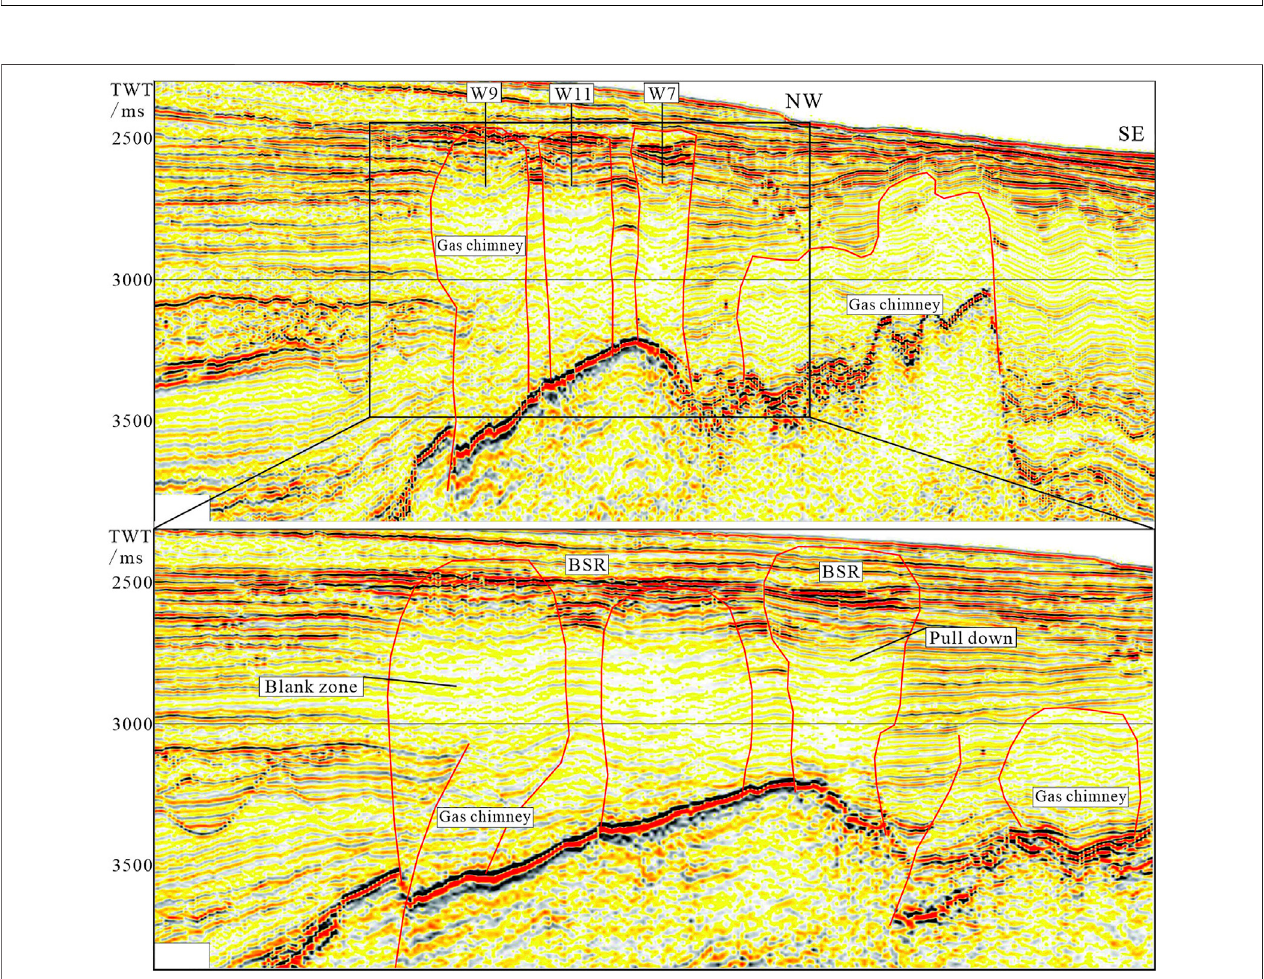
Frontiers in Earth Science |